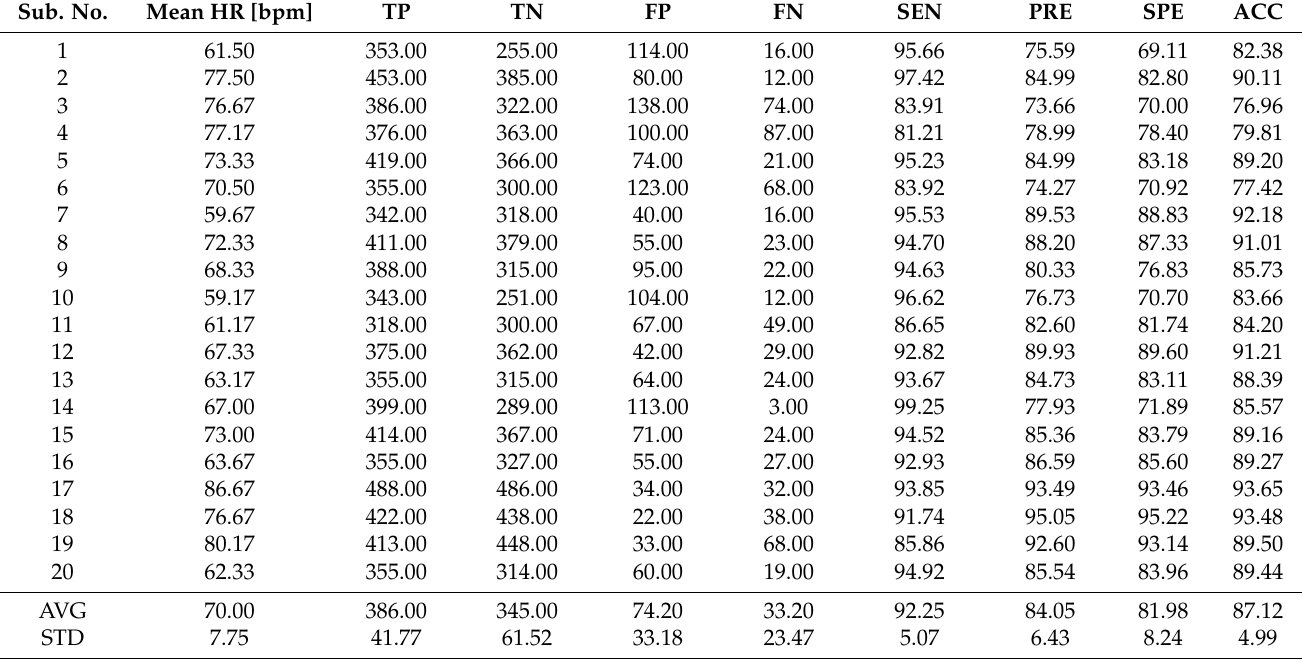
Table 3. Performance of the S1 peak detection in Model I.